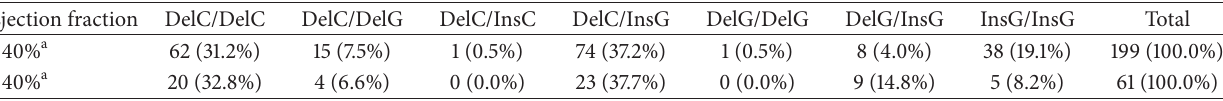
Table 4: Distribution of haplotypes of the 14bp insertion/deletion polymorphism (Del/Ins) and the +3142 SNP (C/G) in the 3 󸀠 -untranslated region of the HLA-G gene in relation to left ventricular ejection fraction.